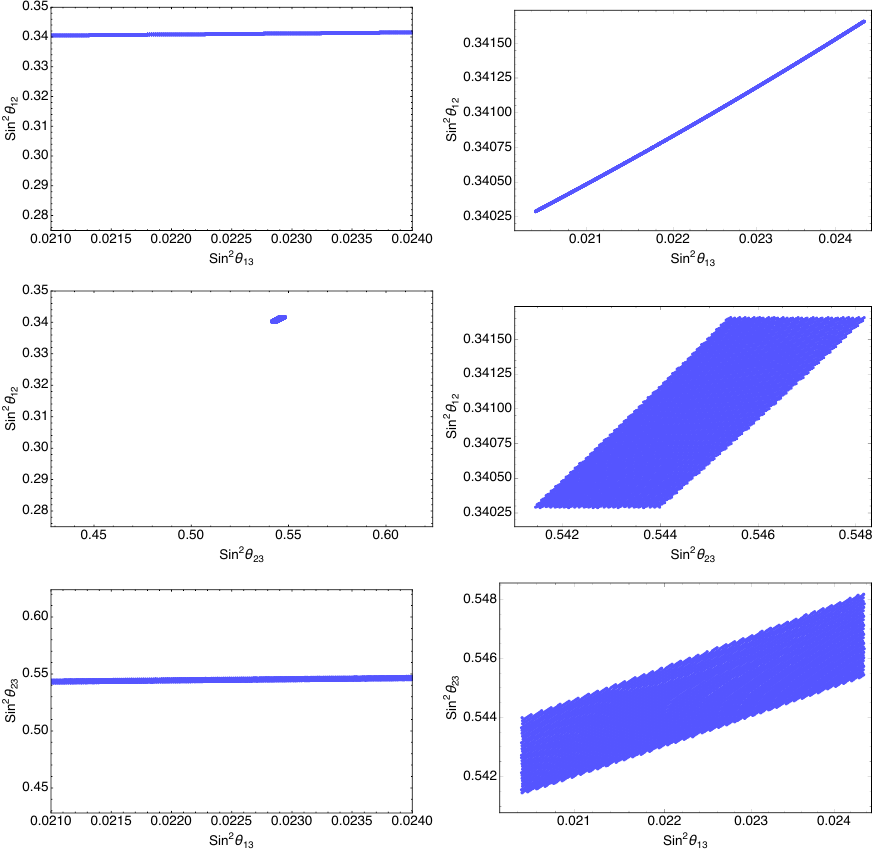
Figure 2 . Correlations among the mixing angles found using equations (4.15)), (4.16 and 4.17. For an explanation please see the text. In the left panel, the predicted ranges of the observables are plotted against their entire 3 (cid:27) ranges. The right panel shows the correlations among the angles which is not clearly visible in the left